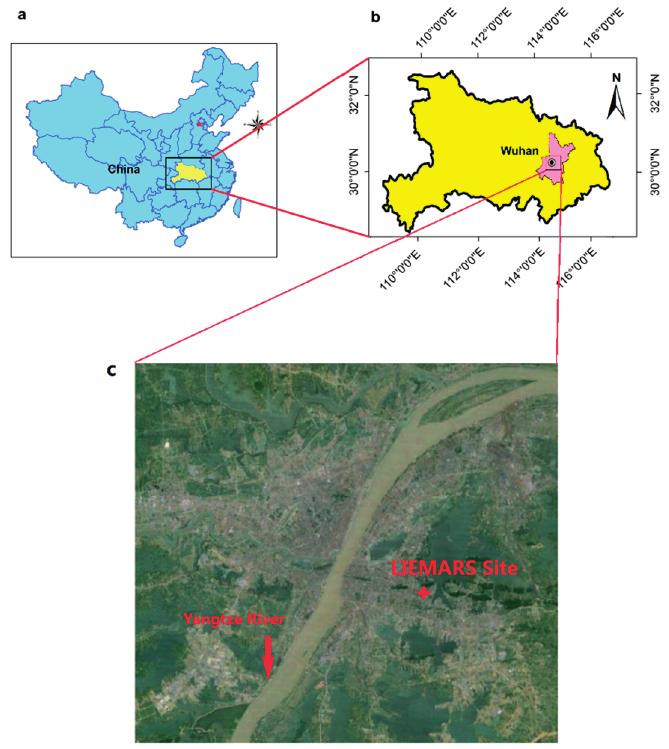
Figure 1. Location of the experimental area: ( a ) location of the Hubei Province in China; ( b ) location of Wuhan city in Hubei Province; ( c ) location of the Laboratory for